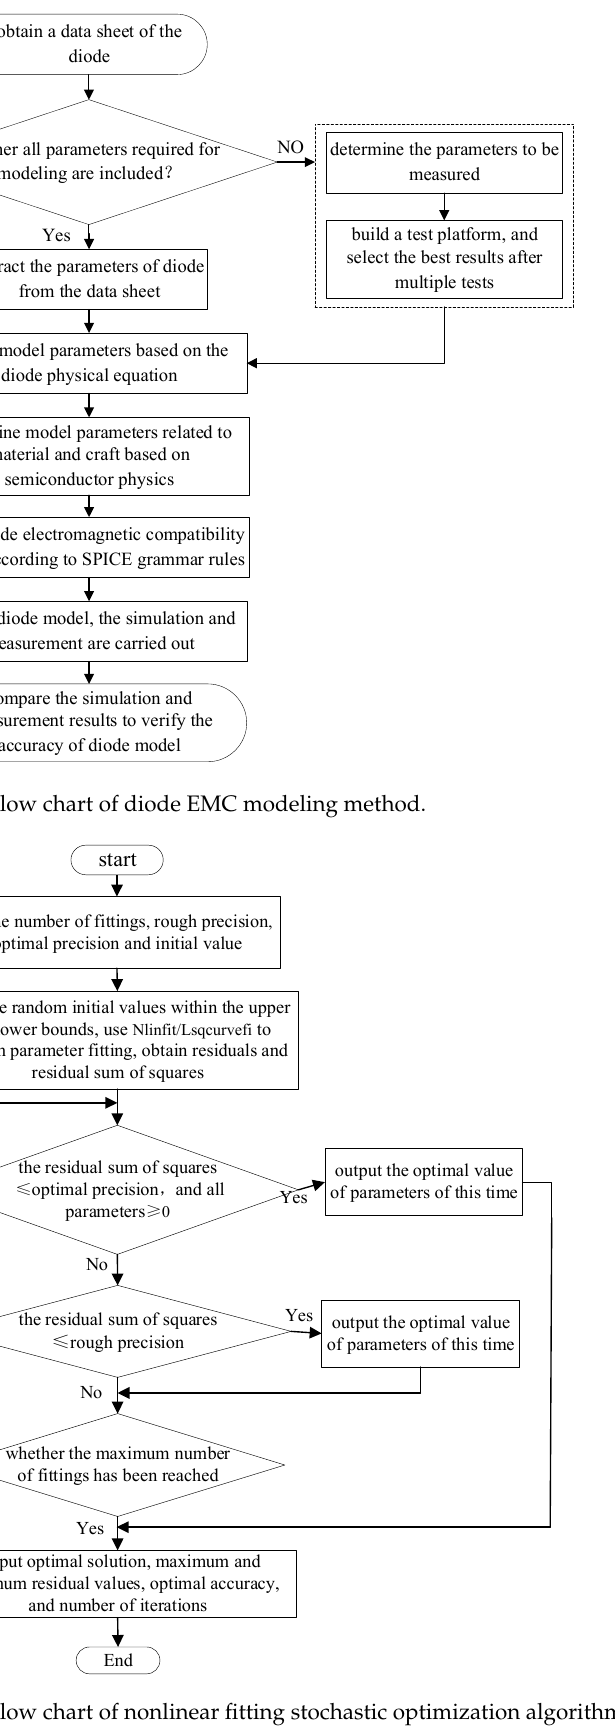
Figure 3. Flow chart of nonlinear fitting stochastic optimization algorithm.